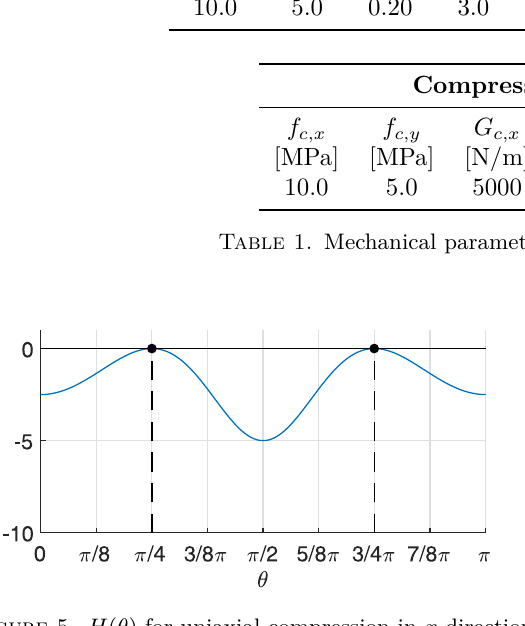
Figure 5. H ( θ ) for uniaxial compression in x -direction